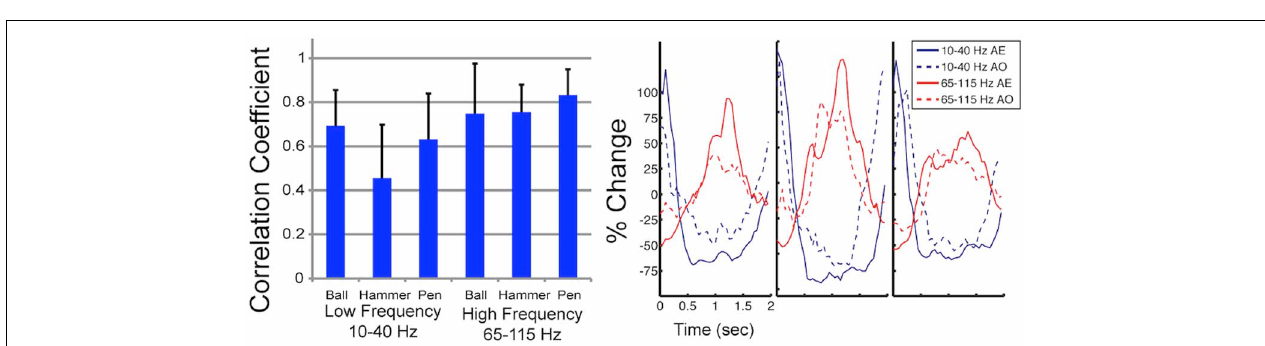
as the percent change from the average activity of a given electrode. For both conditions, a decrease in low frequency spectral power and an increase in high frequency spectral power were observed with a similar temporal profile. Data wasaveragedbasedonstimulusonset(shownasaverticaldottedlineat t = 0).